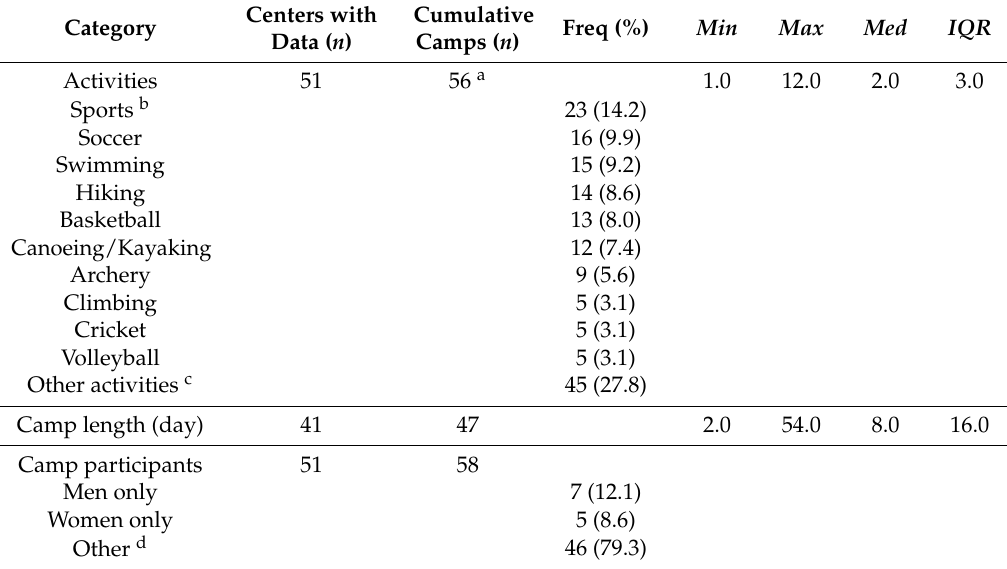
Table 1. Islamic center camp descriptive data ( n = 51